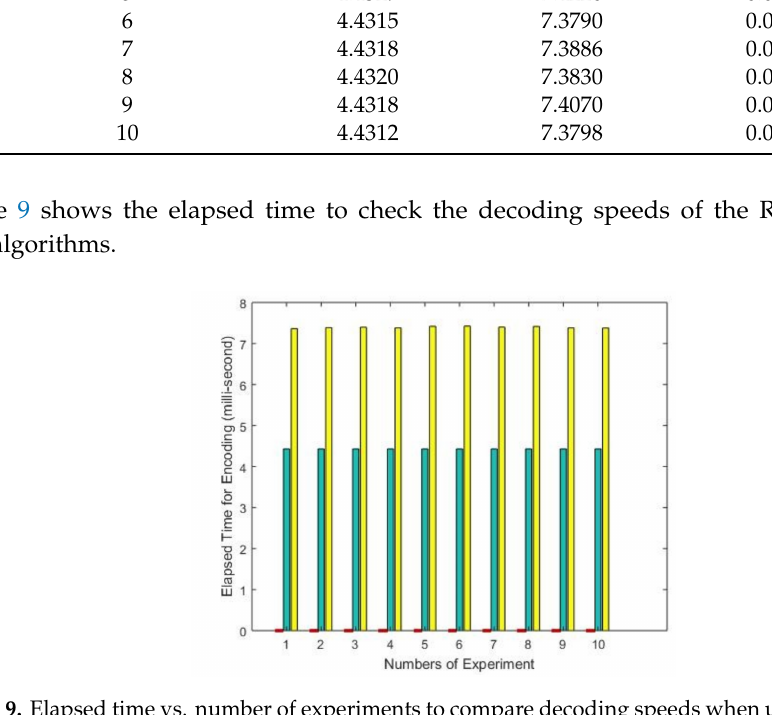
Figure 9. Elapsed time vs. number of experiments to compare decoding speeds when using RSA (green color), ECC (yellow color), and proposed algorithms (red